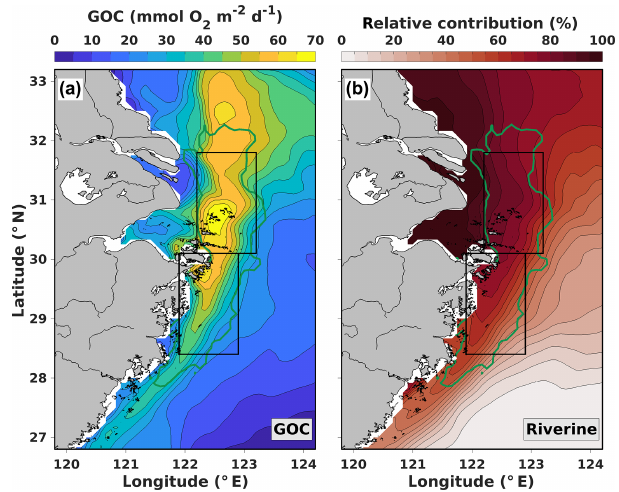
Figure 3. (a) Gross O 2 consumption (GOC) and (b) relative con- tribution supported by nitrogen from rivers (Changjiang and other rivers) averaged from July to November 2008–2013. Green line: area affected by hypoxia. Boxes: analysis regions used in Sect. 3.3 and